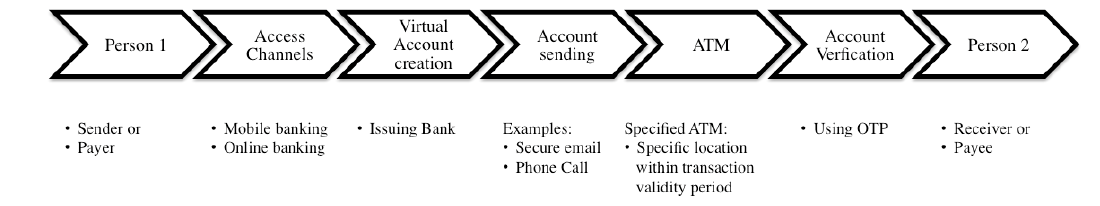
Figure 3. QuickCash Online transaction life